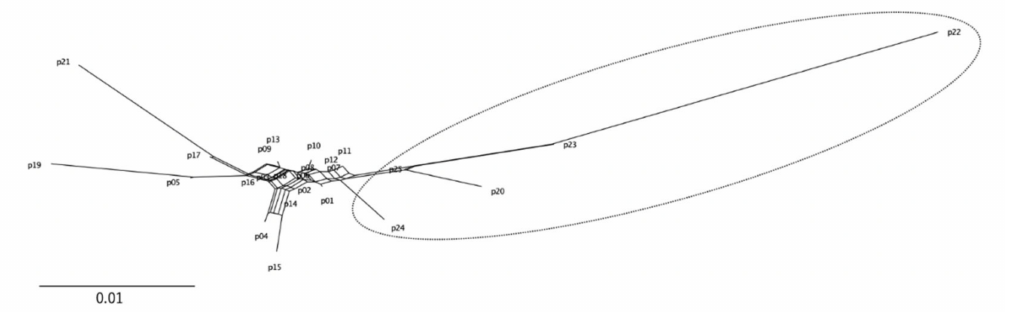
Figure 5. Neighbornet tree among the 25 populations based on Nei’s genetic distances. Southern range populations are grouped by the dotted